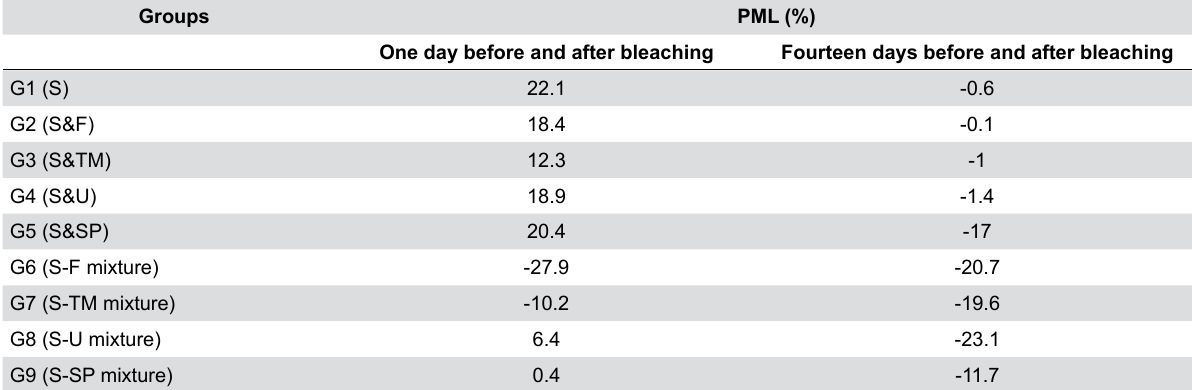
Table 3- The percentage of microhardness loss (PML) (%) between 1 day before and after bleaching and 14 days before and after